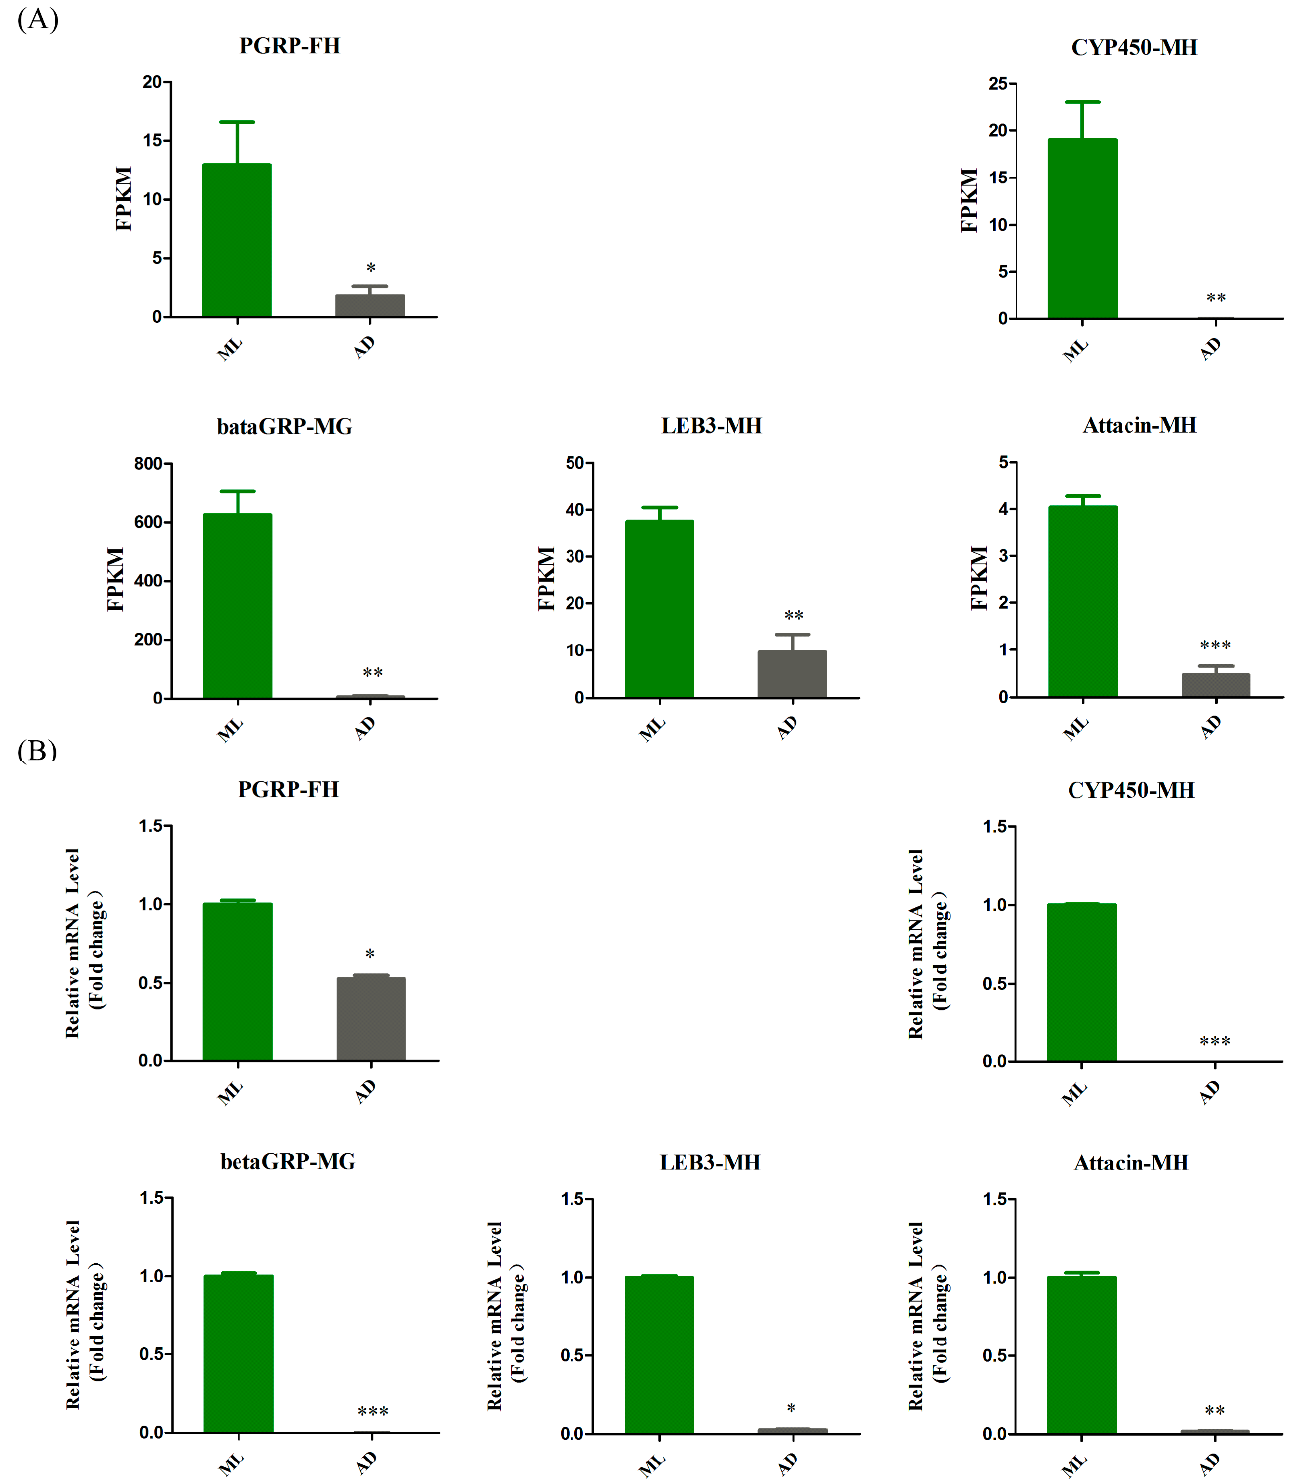
Figure 9. Analysis of differentially expressed genes associated with innate immunity. The expression level of differentially expressed genes was measured by FPKM value ( A ) and qRT-PCR ( B ), ML represented the control group and AD represented the experimental group. The above five congenital immune-related genes were significantly reduced in the experimental group. The student’s t -test was used to evaluate the statistical differences between the samples. A different number of asterisks indicates a difference in significance. (* p -value < 0.05, ** p -value < 0.01, *** p -value < 0.001).